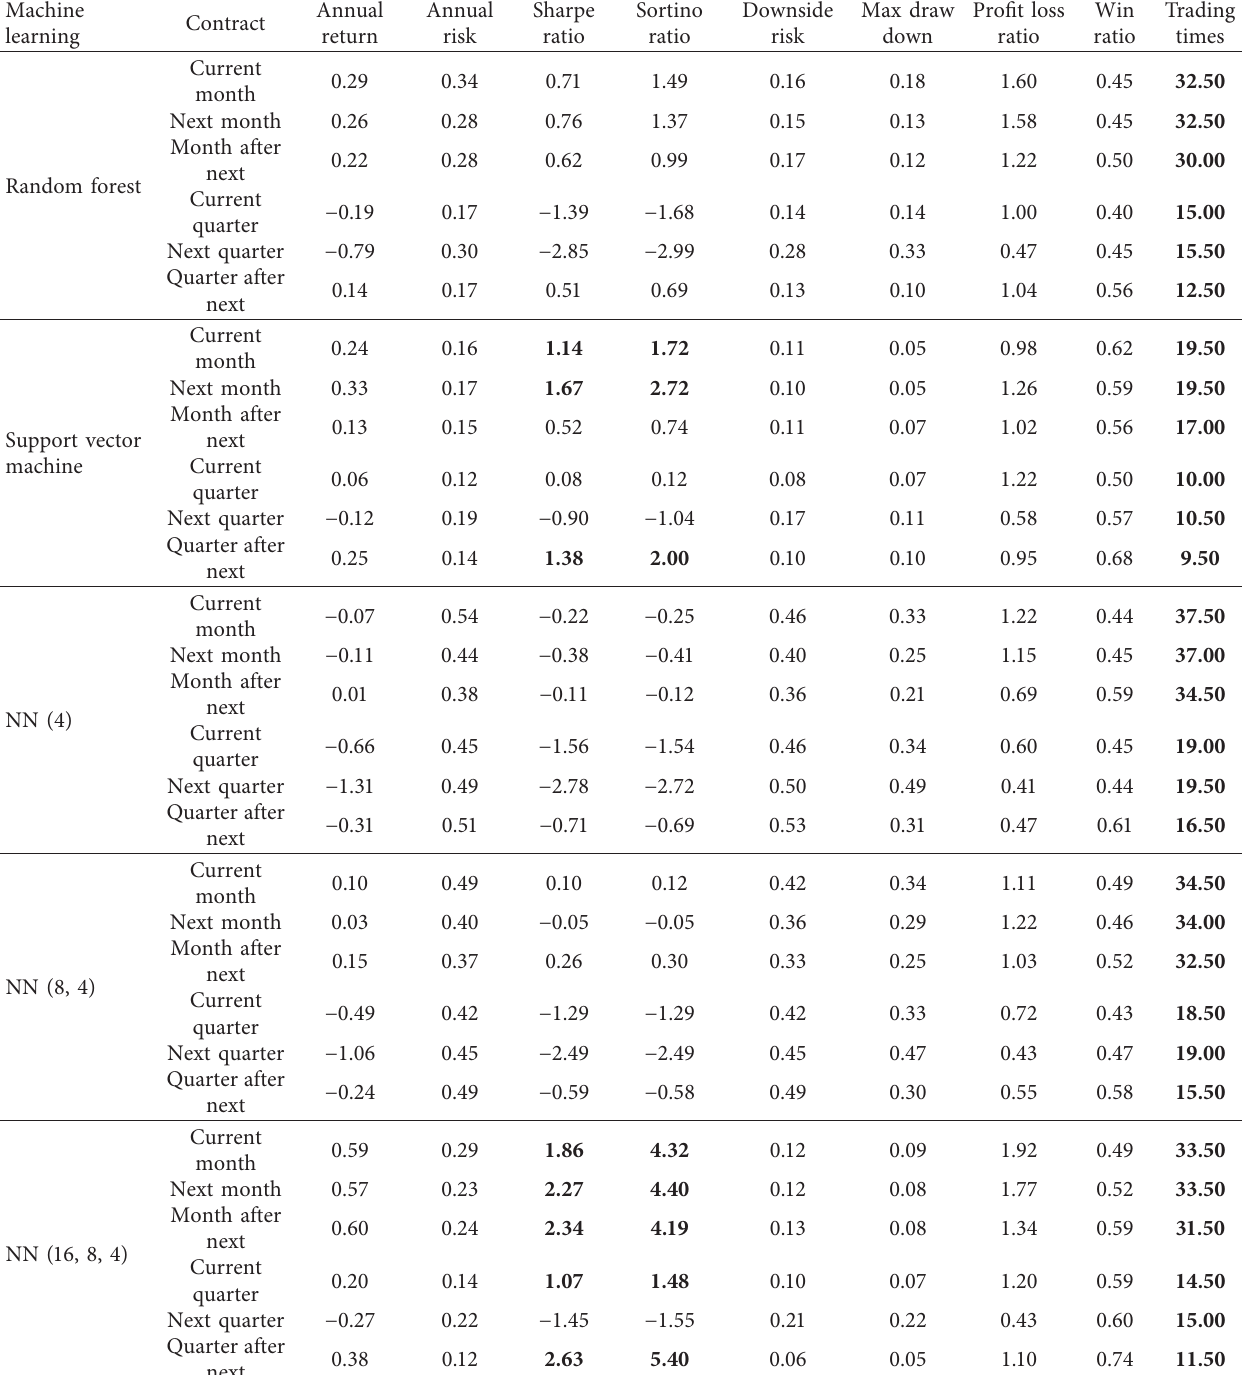
Table 9: Option strategy of predicting the rise and fall of volatility by threshold (use 21 features M3, threshold � 0.3). Machine